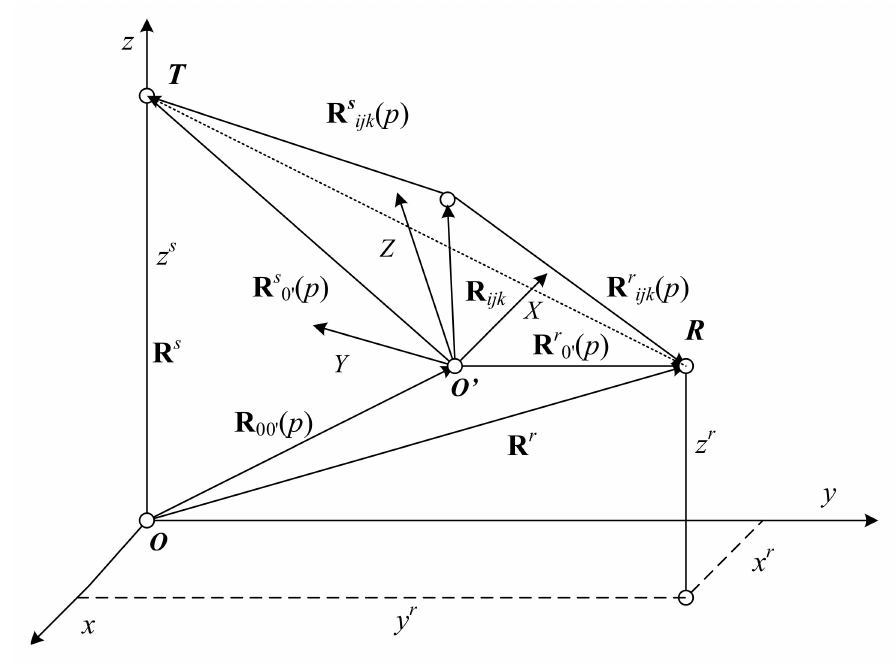
Figure 1. BFISAR